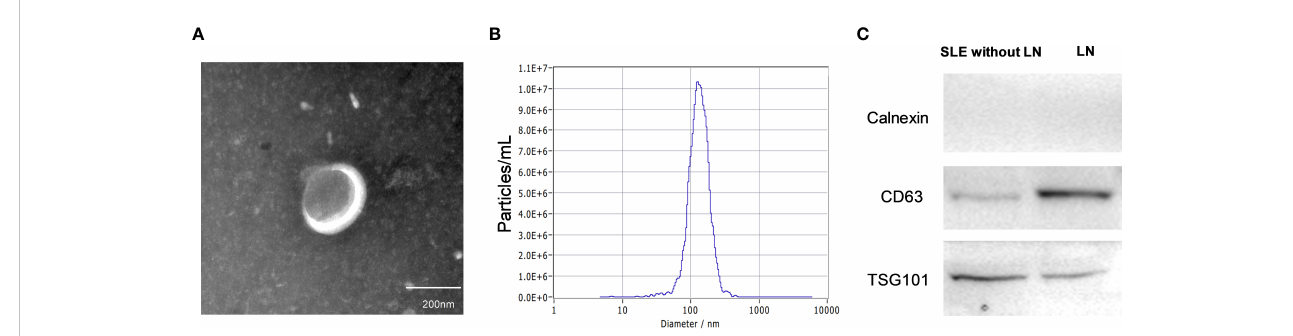
FIGURE 2 Characteristics of urinary exosomes. (A, B) Transmission electron micrograph and nanoparticle tracking analysis con fi rmed that the isolated small vesicles are urinary exosomes (with vesicle of 129 nm average diameters). (C) Western blotting showed the biomarkers of exosomes such as CD63, and